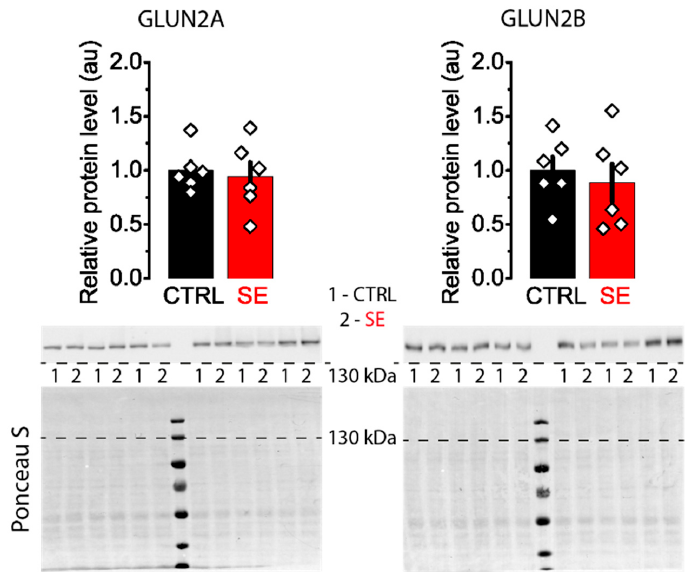
Figure 4. Representative Western blots images of NMDA receptor subunits GluN2A and GluN2B from the dorsal hippocampus of control (CTRL) and experimental (SE) groups. Bar graphs: data presented as mean ± SEM, which were normalized to total protein. T -test, p > 0.05. Each rhombus represents a value obtained in an individual animal. Images: the upper part shows the chemiluminescent signal, and the lower part shows the Ponceau S.